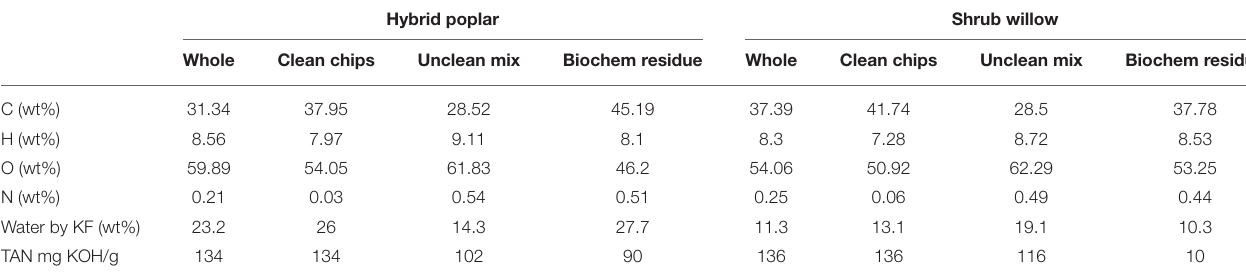
TABLE 5 | Bio-oil properties from fast pyrolysis